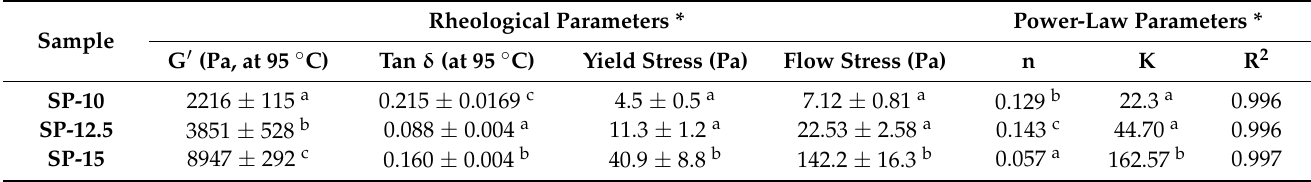
Table 3. Gel strength, loss tangent, yield stress, flow stress, and power-law parameters of the starch pastes with different